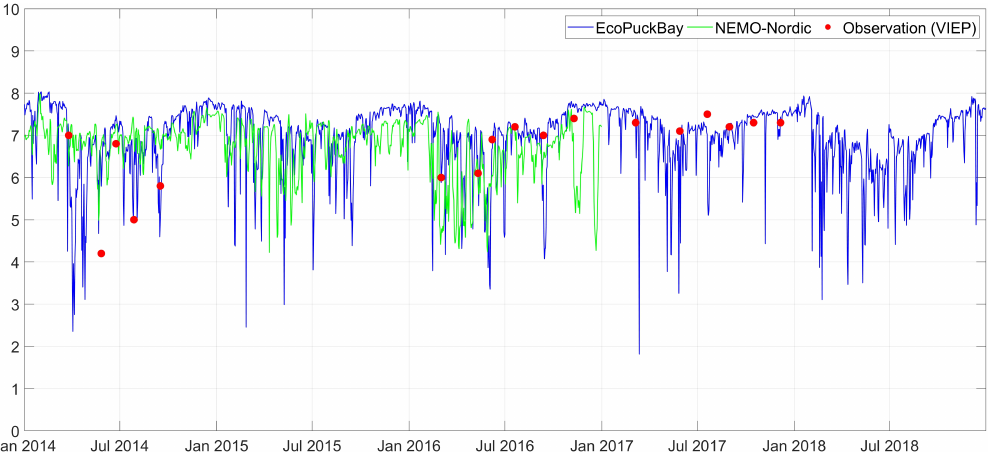
Figure A14. Time series of surface salinity on station T16 compared with VIEP observations and NEMO-Nordic model.